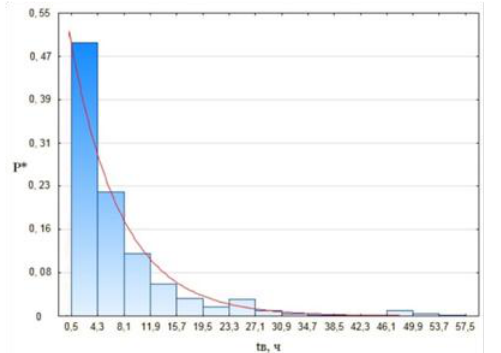
Figure 5. Histograms and distribution frequency functions of restoring time of an electric part of rope shovels